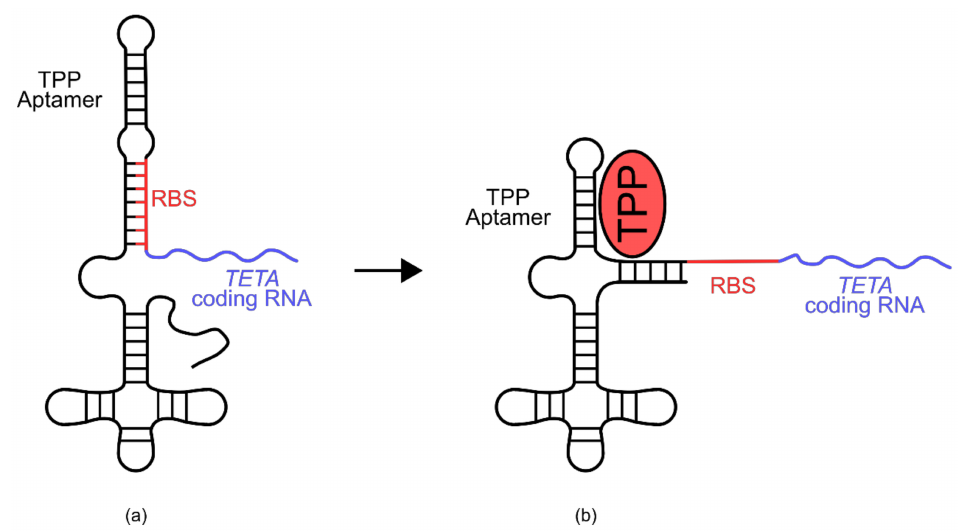
Figure 9. Thiamine pyrophosphate (TPP) biosensor. The biosensor is comprised of a TPP-binding aptamer, a TETA -coding RNA, and a modified spacer sequence containing the ribosomal binding site (RBS): ( a ) Biosensor without TPP. Base pair homology keeps the RBS inaccessible to the ribosome, preventing translation of the TETA -coding RNA; ( b ) TPP biosensor coordinated to TPP. Coordination allows a more energetically favorable secondary structure to be adopted, which liberates the RBS, allowing translation of the TETA -coding RNA. Under increased TPP concentration conditions, E. coli cells containing this biosensor are able to grow in the presence of the antibiotic tetracycline. Figure adapted from Muranaka, et al. [77].